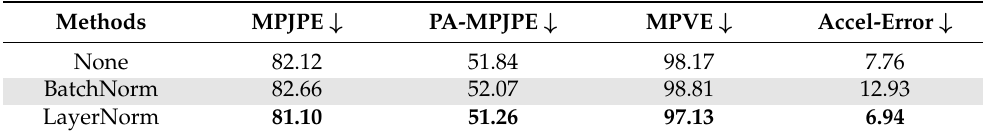
Table 4. Comparison of refinement performance of HPR-Net according to feature normalization method. Bold values indicate best